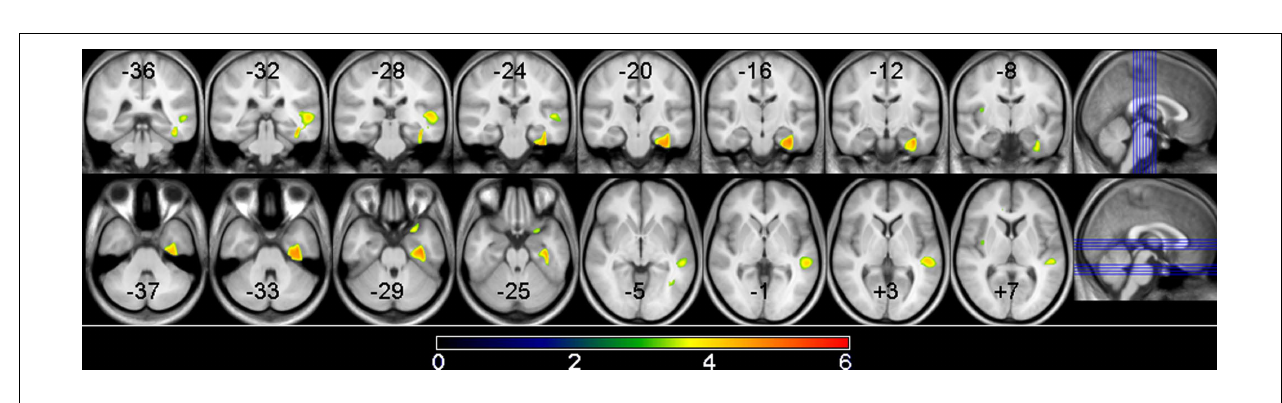
significance level of p < 0.05, cluster corrected. Shown here is the right parahippocampal gyrus/superior temporal gyrus result.The location of the 8 coronal and axial slices are illustrated on the sagittal planes with coordinates presented in MNI space.The color bar indicates the t-